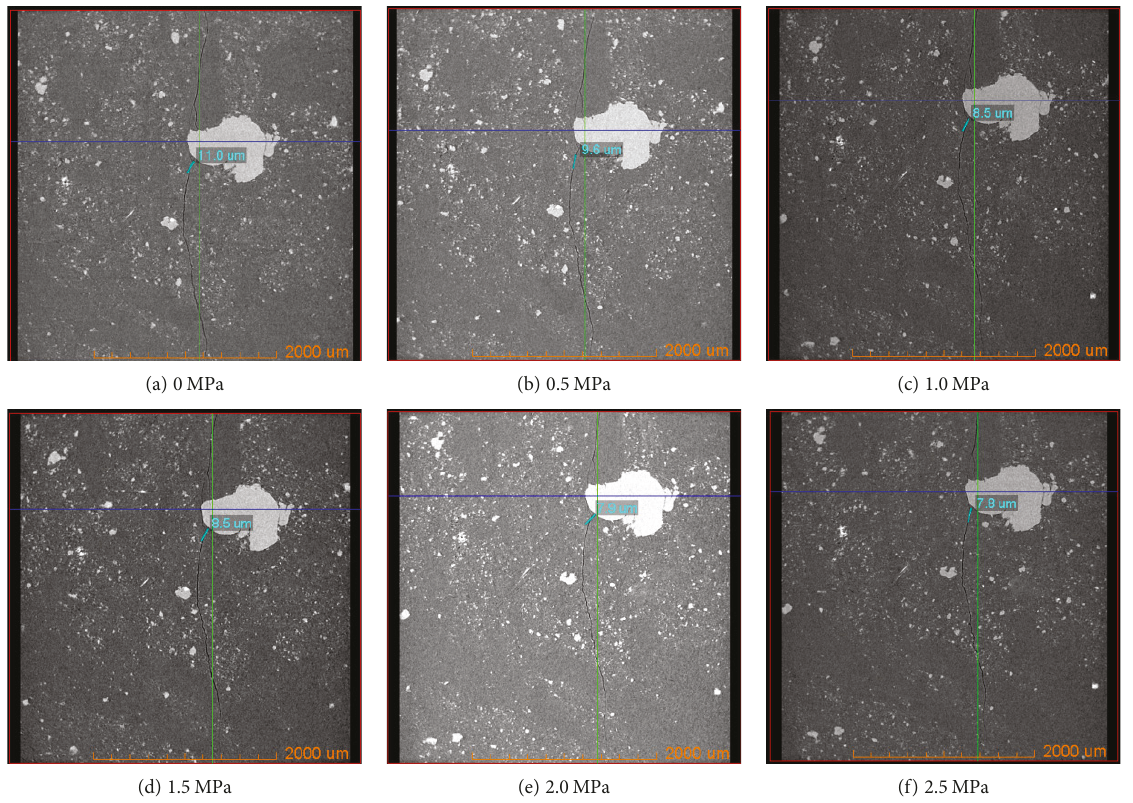
Figure 10: CT images of fracture size (yz section).